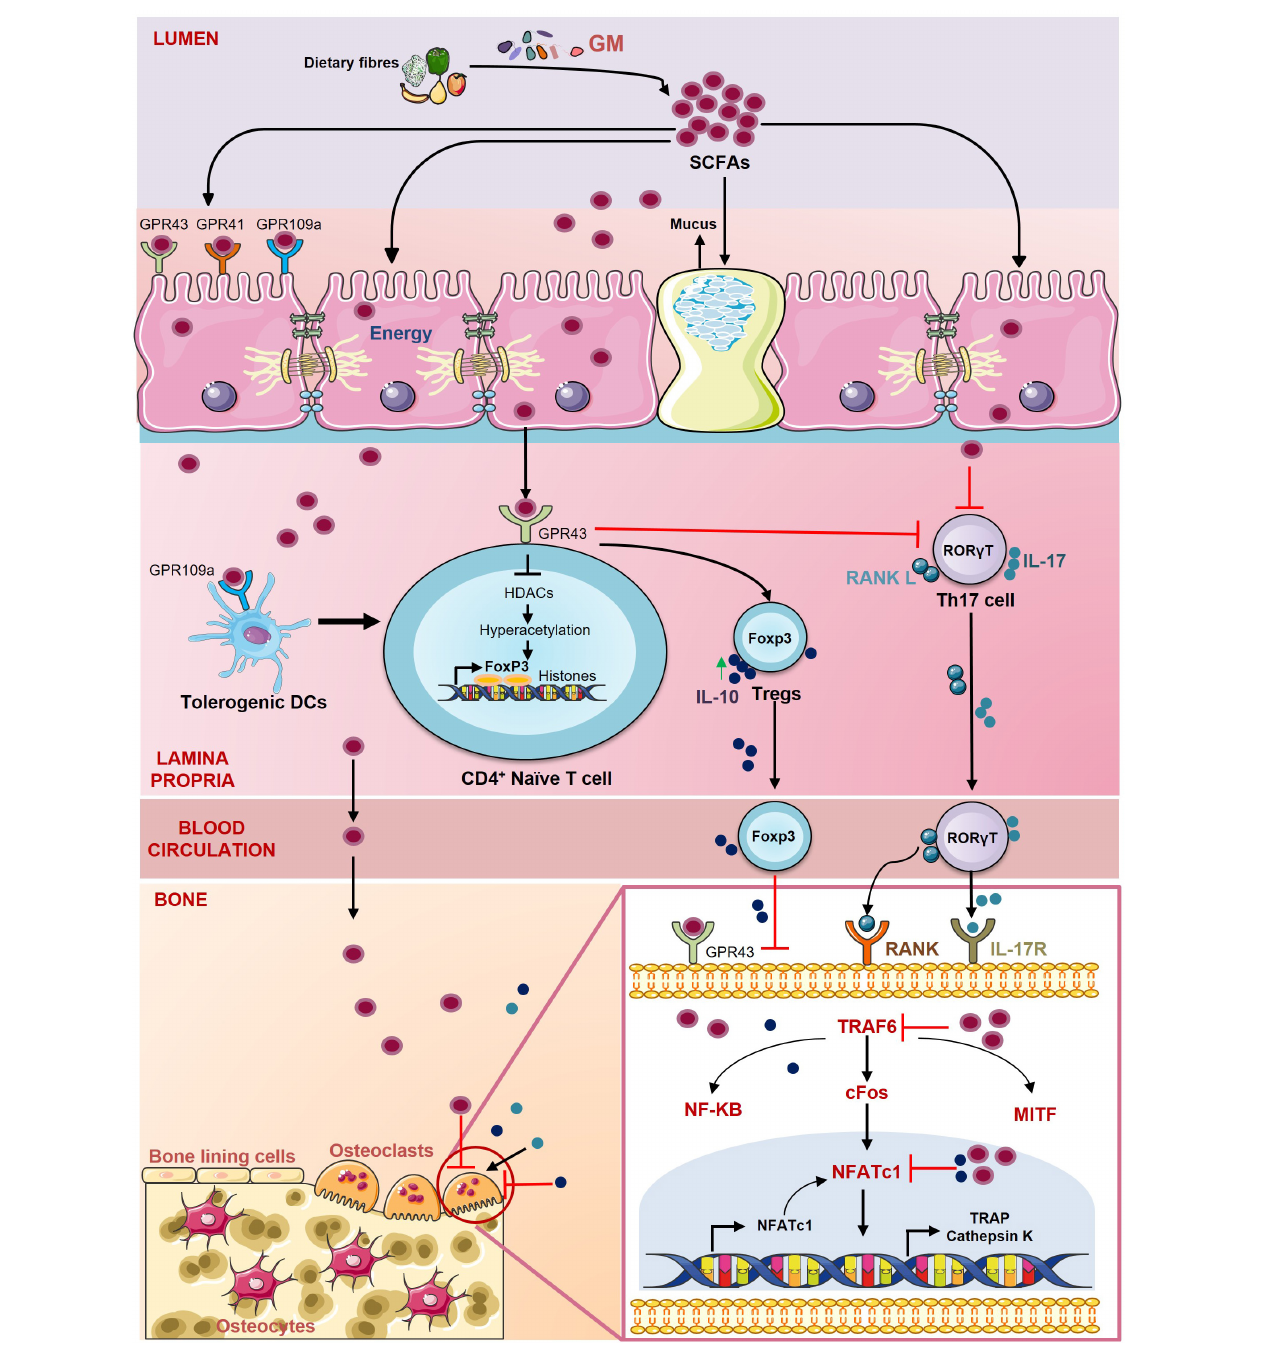
FIGURE 6 | Role of short-chain fatty acids (SCFAs) in regulating Bone Health. SCFAs are the energy source for the epithelial cells and regulate the activity of various hematopoietic and non-hematopoietic cells through the G protein-coupled receptors (GPCRs) such as GPR41, GPR43, GPR109a. SCFAs promote the differentiation of Tregs through inhibition of histone deacetylases (HDACs) and suppress the secretion of IL-17 from Th17 cells. SCFAs also stimulate the development of Tregs by inducing tolerogenic DCs. SCFAs inhibit the differentiation of osteoclasts by downregulating the expression of key osteoclastogenic markers TRAF6 and NFATc1.